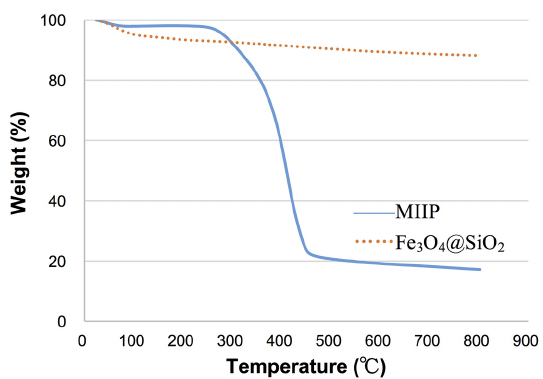
Figure 4. Magnetization hysteresis loops of Fe 3 O 4 ( a ) and MIIP ( b ).